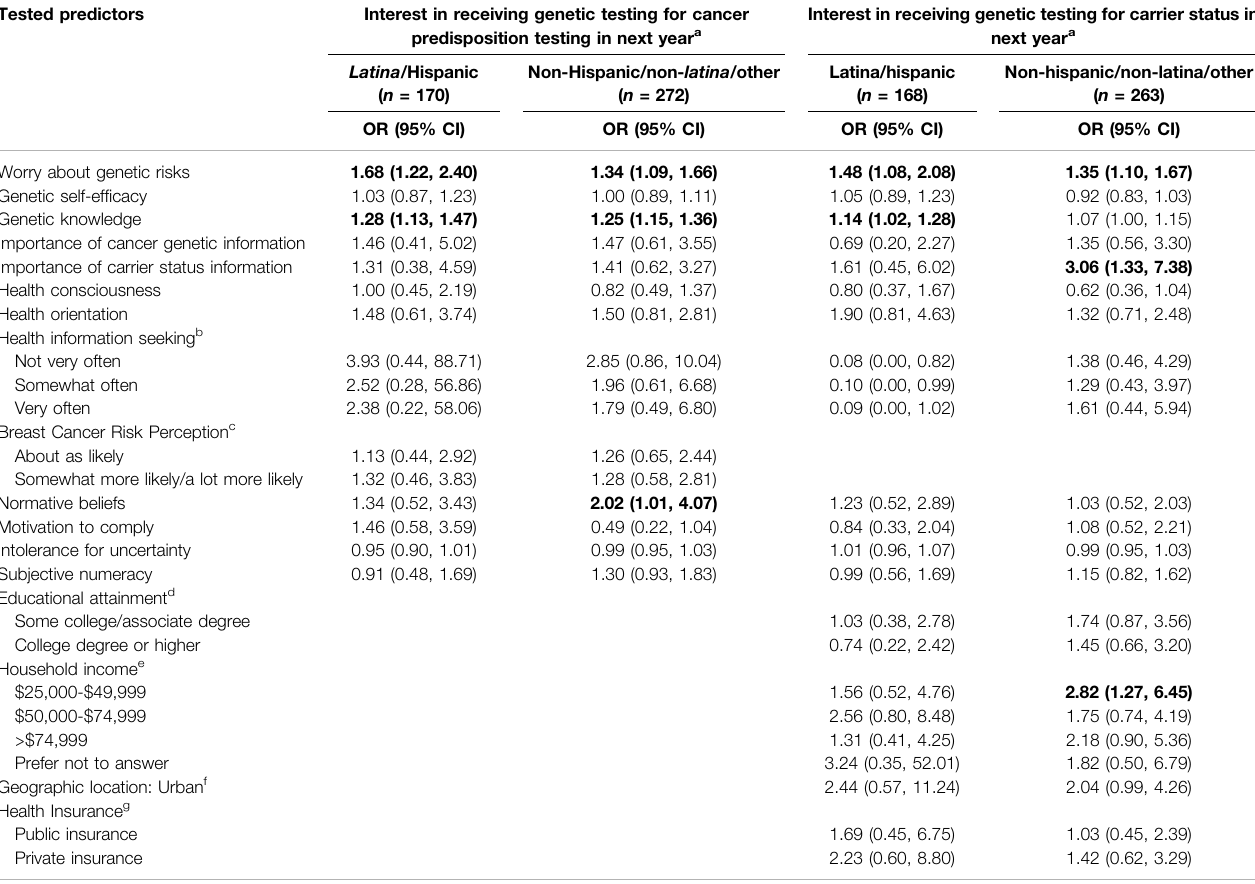
TABLE 7| Multivariablelogisticregressionmodels, strati fi edbyethnicity,showingpredictors ofinterest inreceivingcancerpredispositiontesting andcarrier screeninginthe next year. Tested